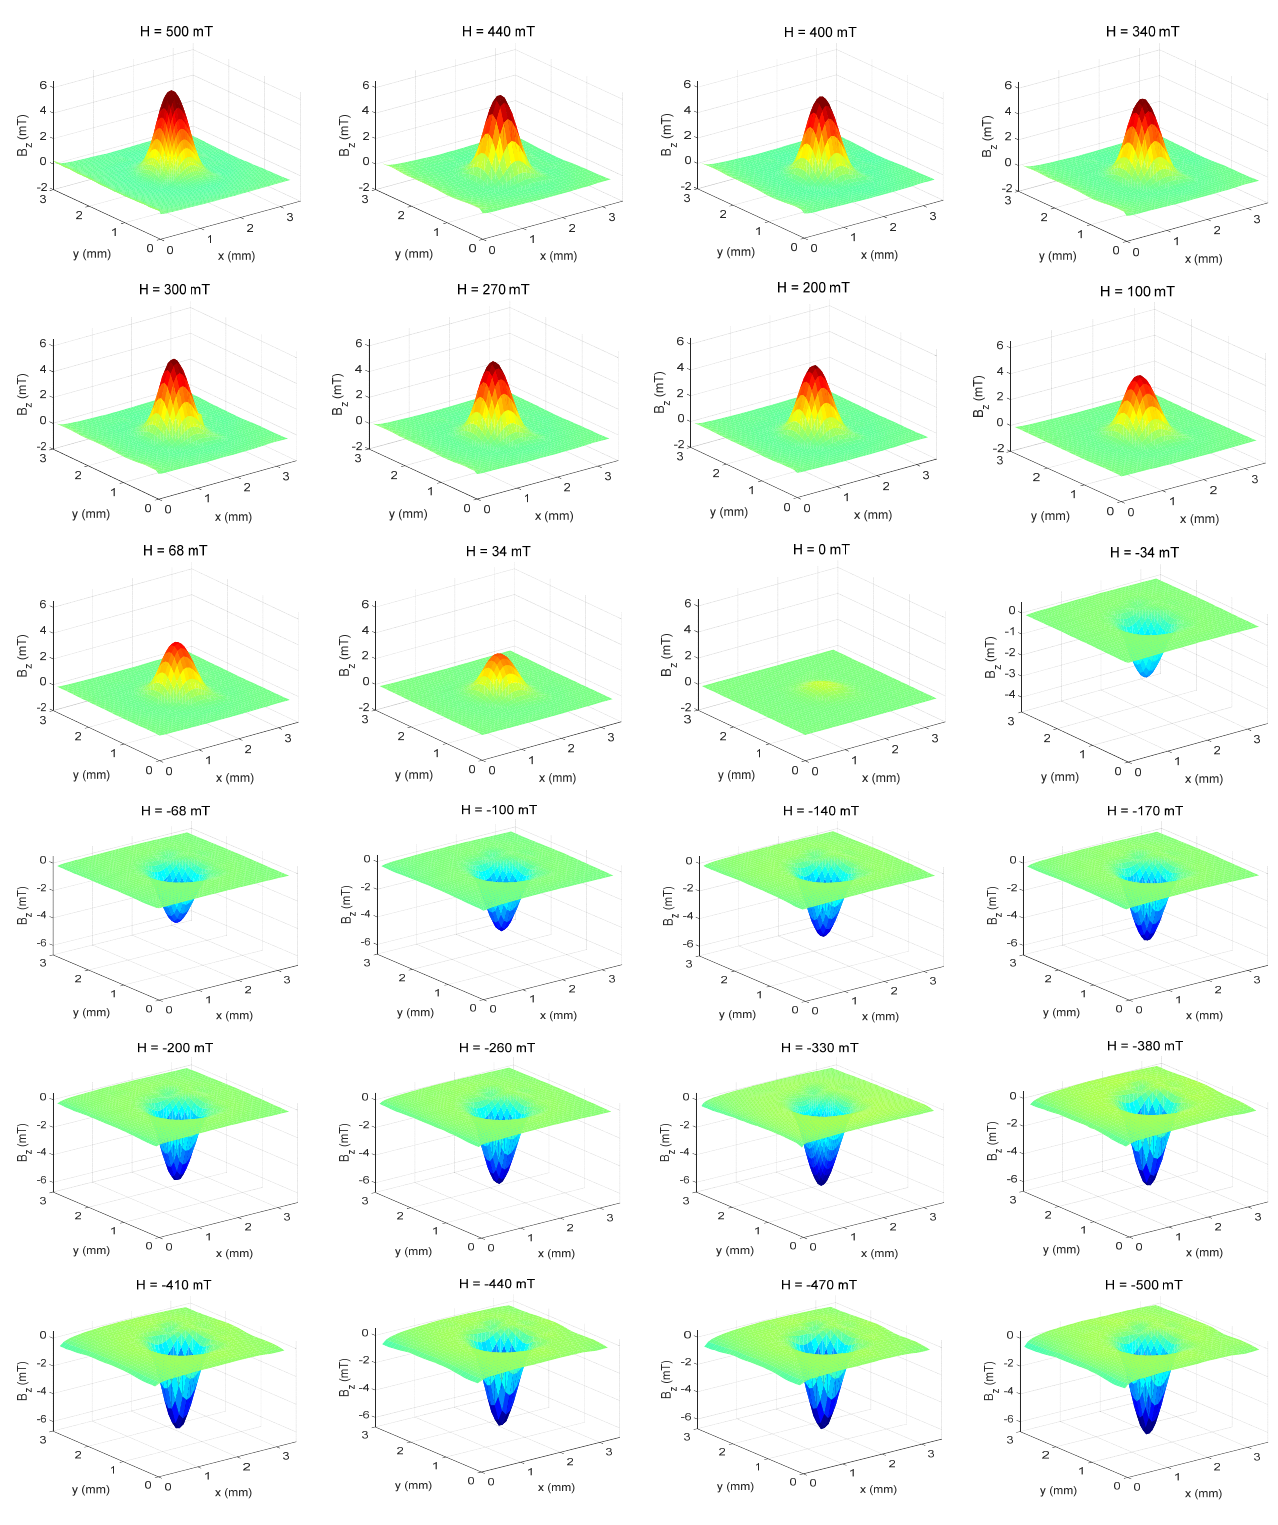
Figure 12. Magnetic maps of the sample NP0 in 3D, obtained directly from the maps in XY space from 500 mT to − 500 mT.